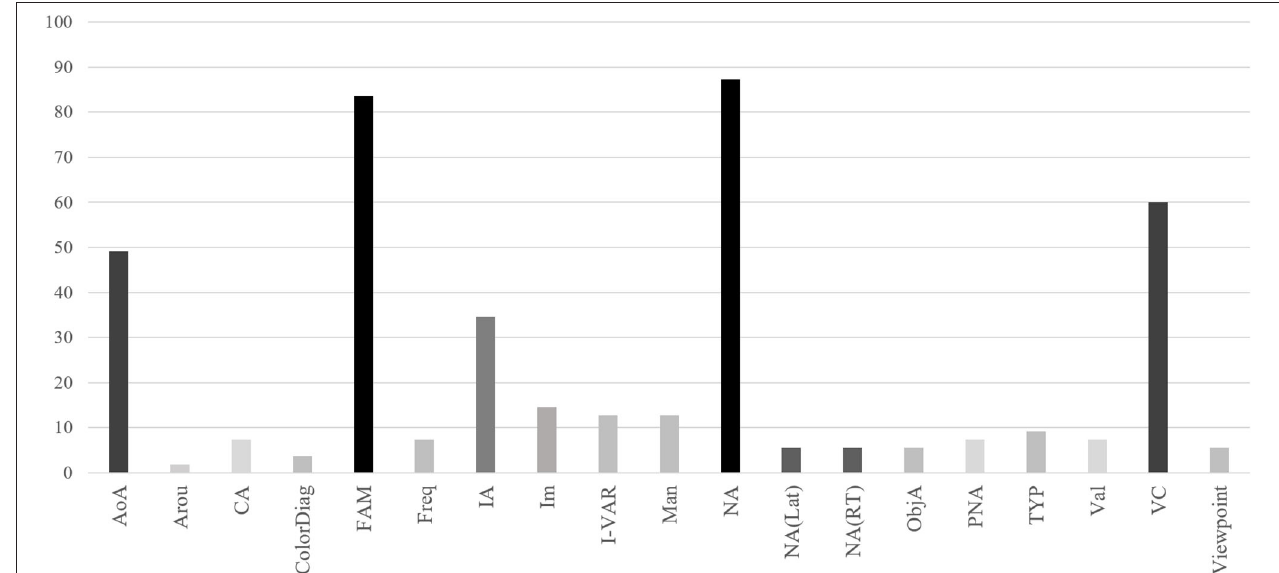
FIGURE 3 | Representativeness of each dimension across studies